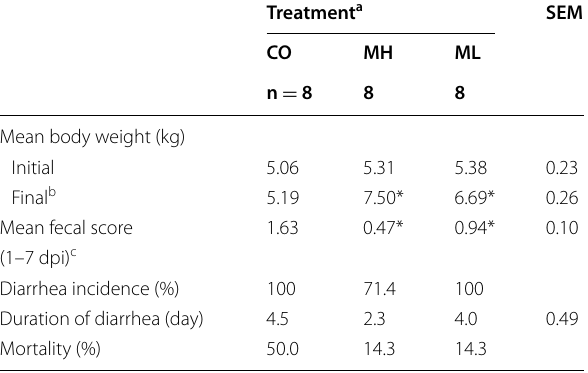
Table 4 Effect of diet mixed with EC12 and SCE against PWD in weaning pigs